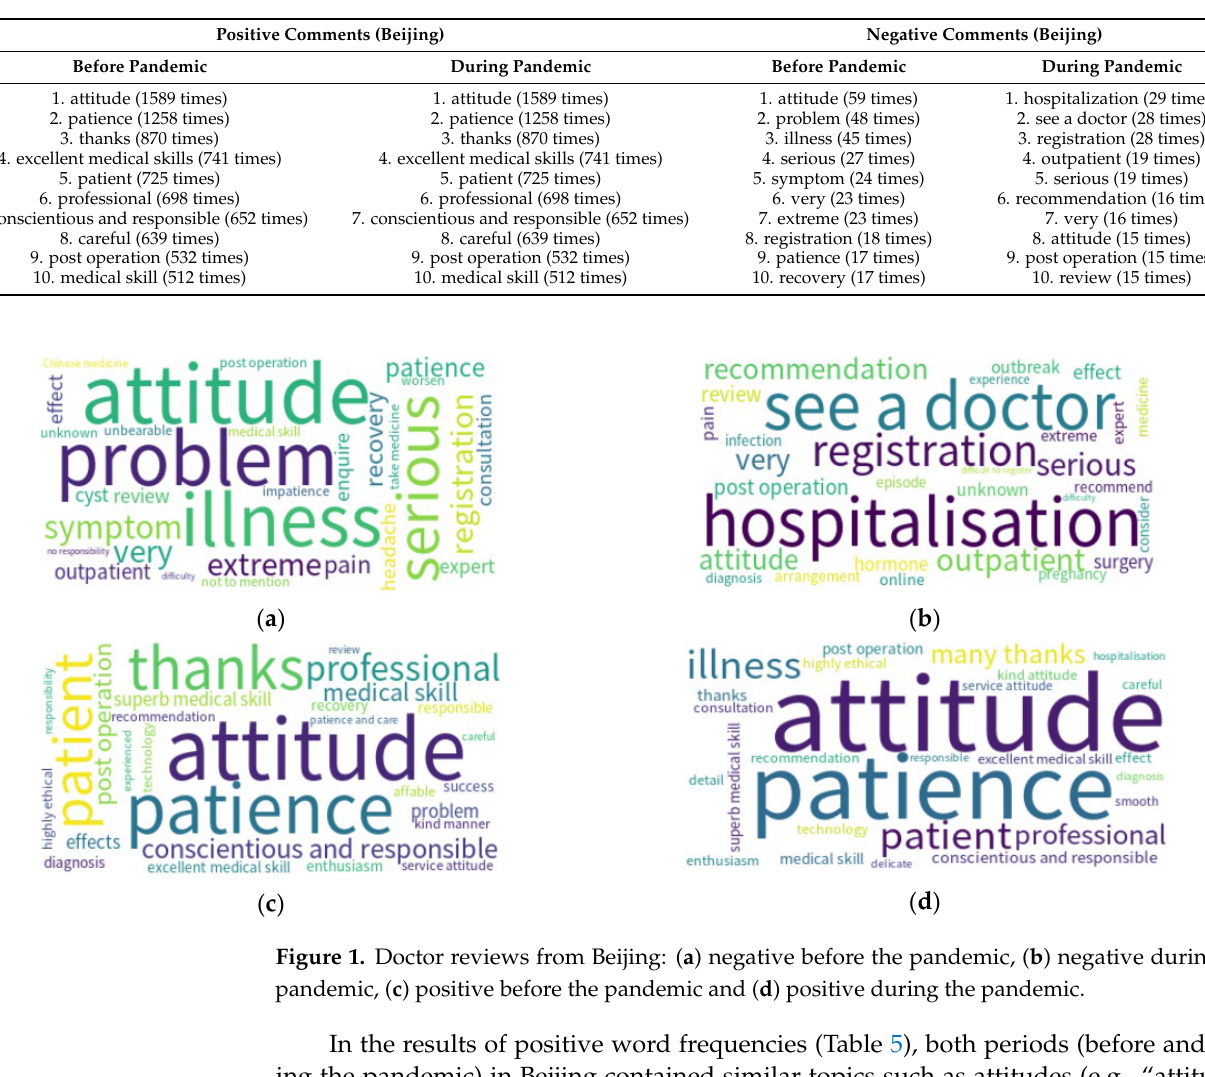
Table 6. Frequently Used Words in Comments (Shanghai).